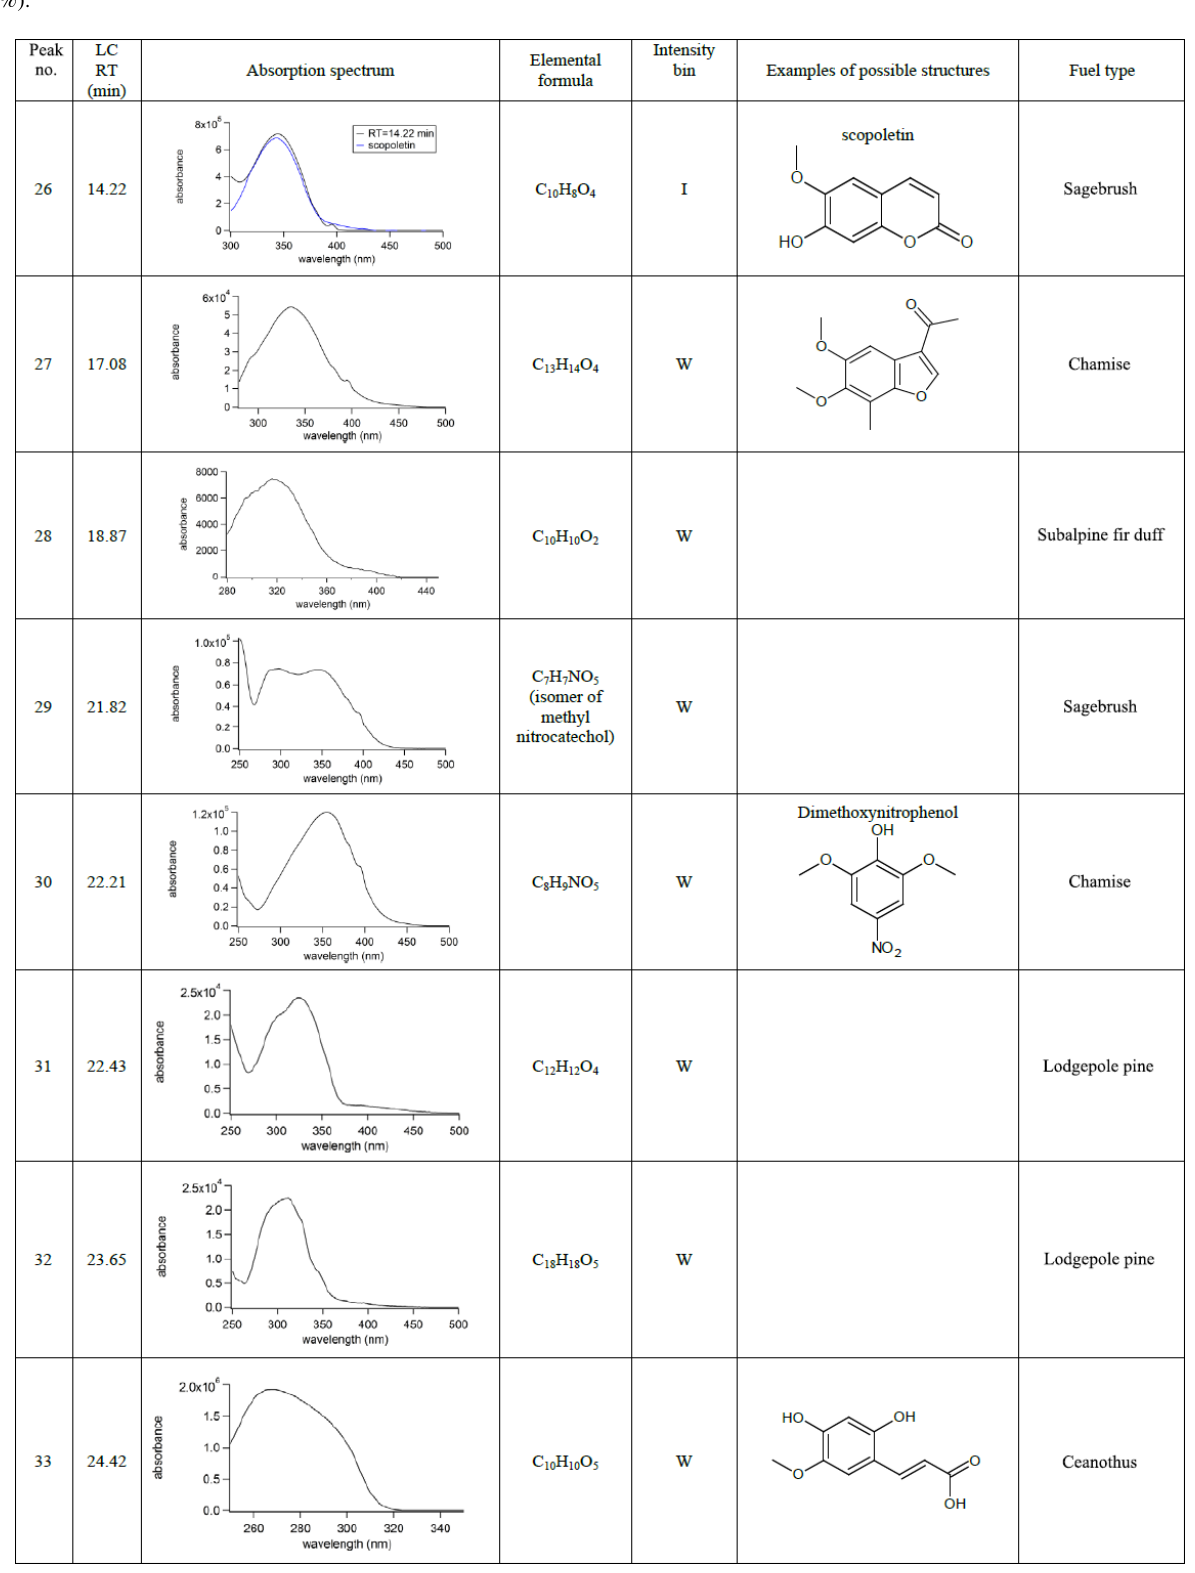
Table 2. Chromophores appreciably found in only one fuel type, listed by their HPLC retention time, absorption spectra, assigned elemental formulas, and examples of possible structures. The absorbance by each chromophore is binned by integrated photodiode array absorbance normalized to the highest absorbance in each chromatogram: M – major (75%–100%); I – intermediate (25%–75%); or W – weak (5%–